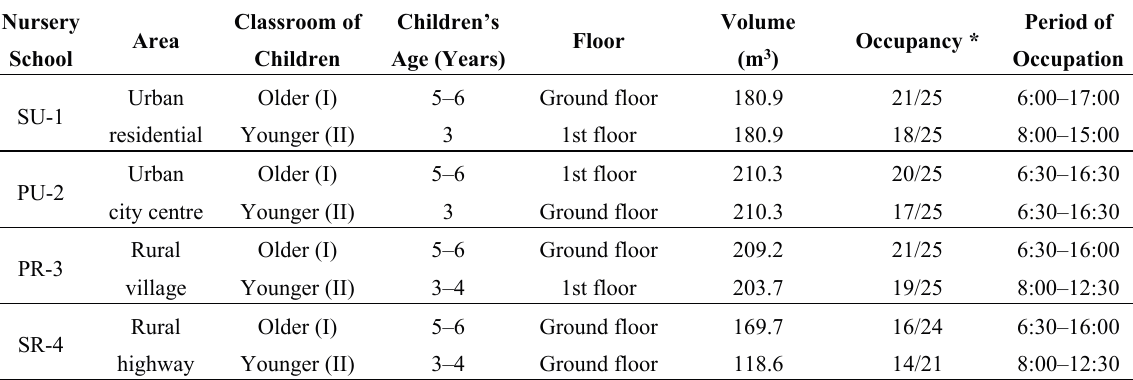
* Median occupancy of children during winter/number of children in